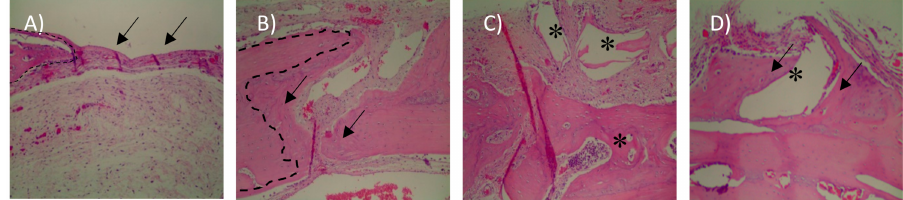
Figure 4. Histological images after 15 days (100 × magnification). ( A ) Blood clot group (G1), arrows indicate Osteotomy region and dashed line represent the stump; ( B ) autogenous bone group (G2), observe new bone formation between the stump (dashed line) and the autogenous graft fragment; ( C ) xenogenous bone group (G3)—the asterisks show the particles Bio-Oss ® ; ( D ) xenogenous bone associated with the micro graft group (G4)—observe the new bone formation around the Bio-Oss ® particles.